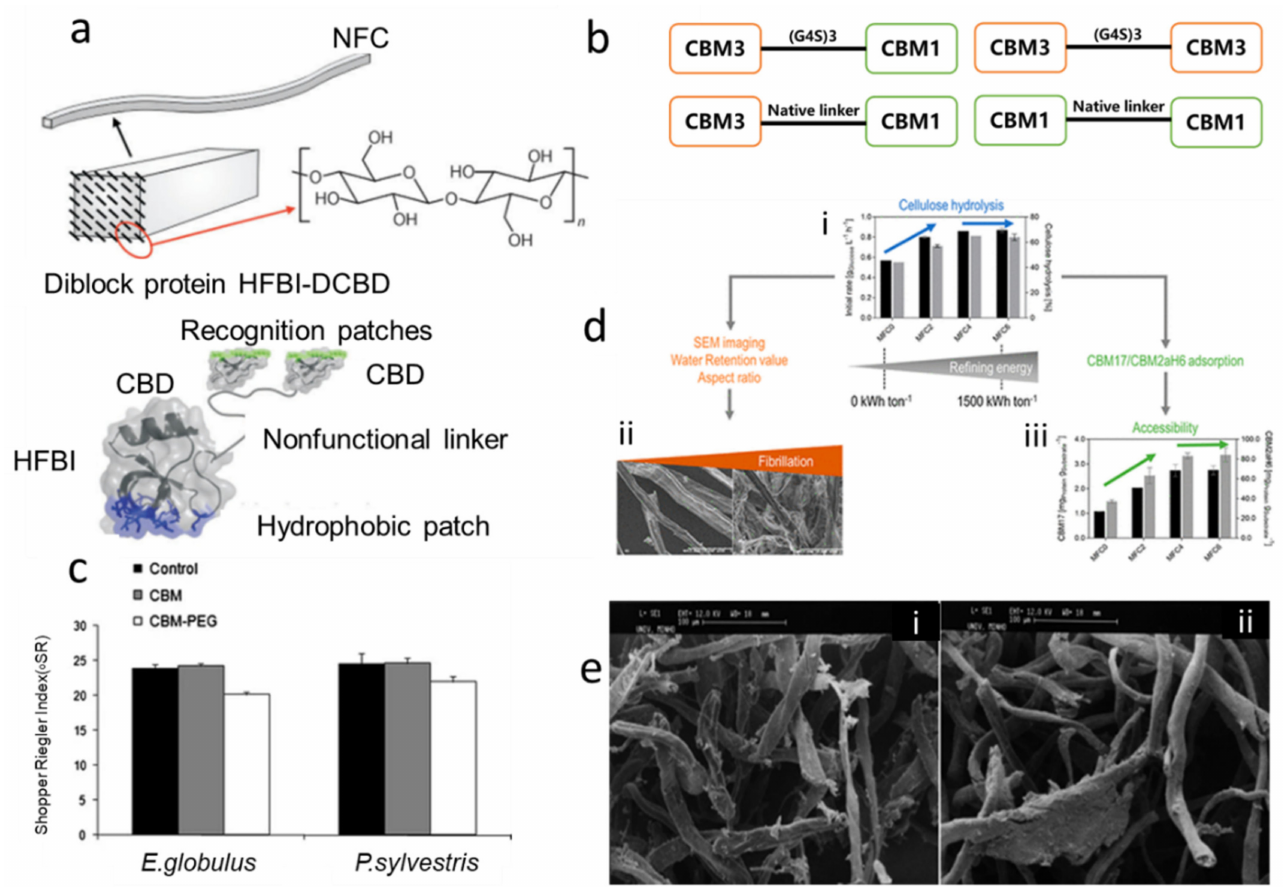
Figure 3. ( a ) A schematic presentation of the structure of the composite, reprinted from Ref [115] with permission from John Wiley and Sons. At the molecular level there are two functional blocks of the fusion protein amphiphilic hydrophobin − cellulose − binding domains (HFBI-DCBD) and its target surfaces; ( b ) Schematic structures of double CBMs, adapted from Ref [116]; ( c ) Shopper − Rieler Index of the E. globulus and P. sylvestris fibers treated with CBM, CBM-PEG and untreated, reprinted from Ref [67] with permission from Springer Nature; ( d ) ( i ) Impact of increasing refining energies on ease of enzyme − mediated hydrolysis of the microfibrillated cellulose (MFC) substrates. ( ii ) Impact of the refining energy on the fiber morphology. ( iii ) Impact of increasing refining energies on cellulose − binding module accessibility to the MFC substrates, reprinted from Ref [87] with permission from American Chemical Society; ( e ) SEM images of CF11 fibers treated with ( i ) and without ( ii ) CBD, reprinted from Ref [113] with permission from American Chemical